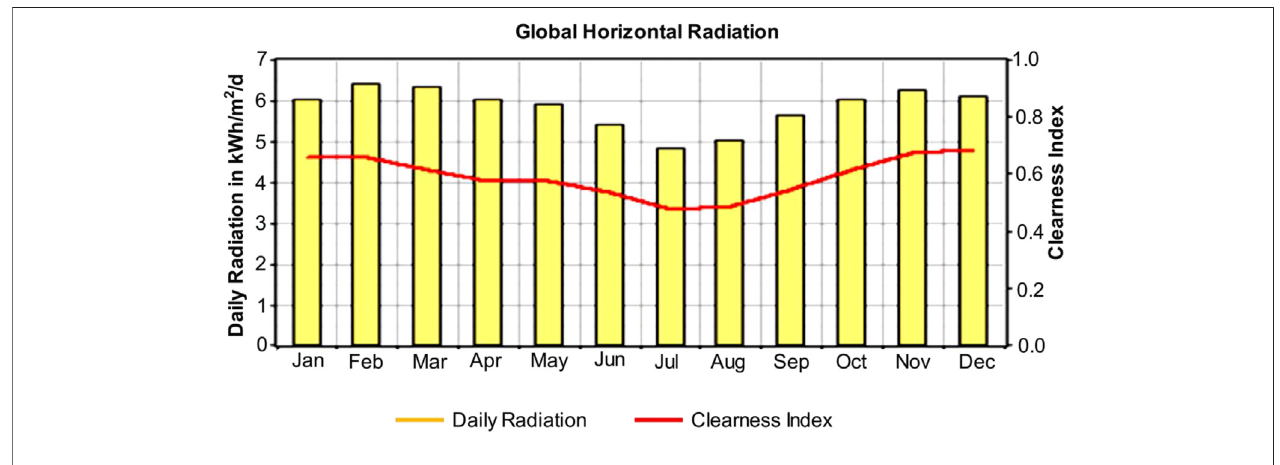
FIGURE 1 | Global horizontal radiation of Hawassa.